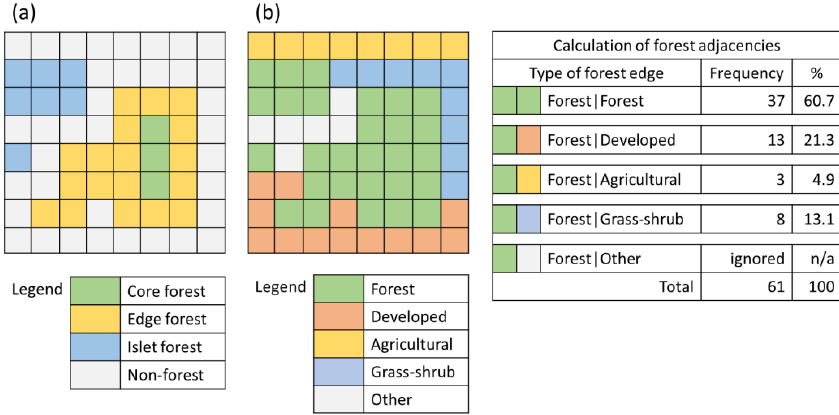
Figure 1. Illustrations of ( a ) morphological spatial pattern analysis classes, and ( b ) calculation of forest adjacencies. In ( a ), each pixel is labeled by the indicated class; in ( b ), an “edge” refers to an adjacent pair of pixels (cardinal directions), the edges not involving forest are ignored, and each pixel is characterized by the edges in its unique surrounding “window”.